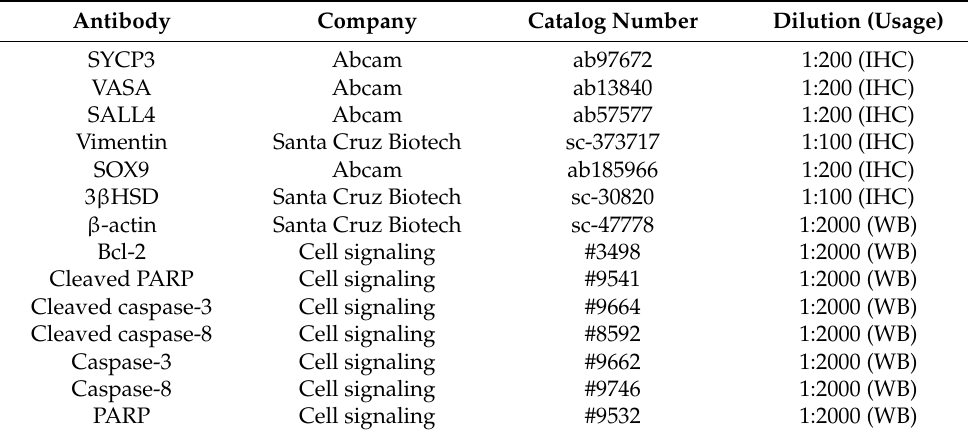
Table 1. List of antibodies used for